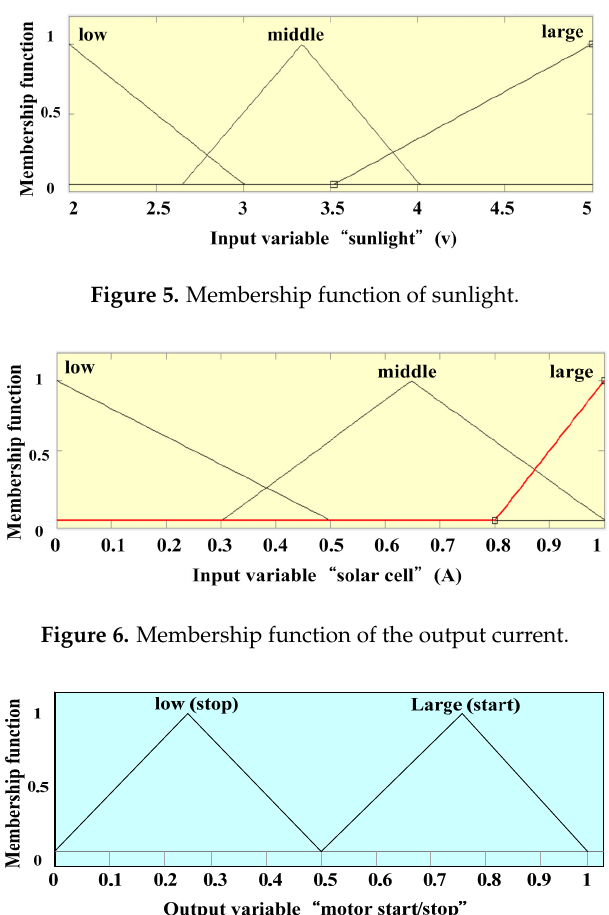
Figure 7. Membership function of the consequent part.